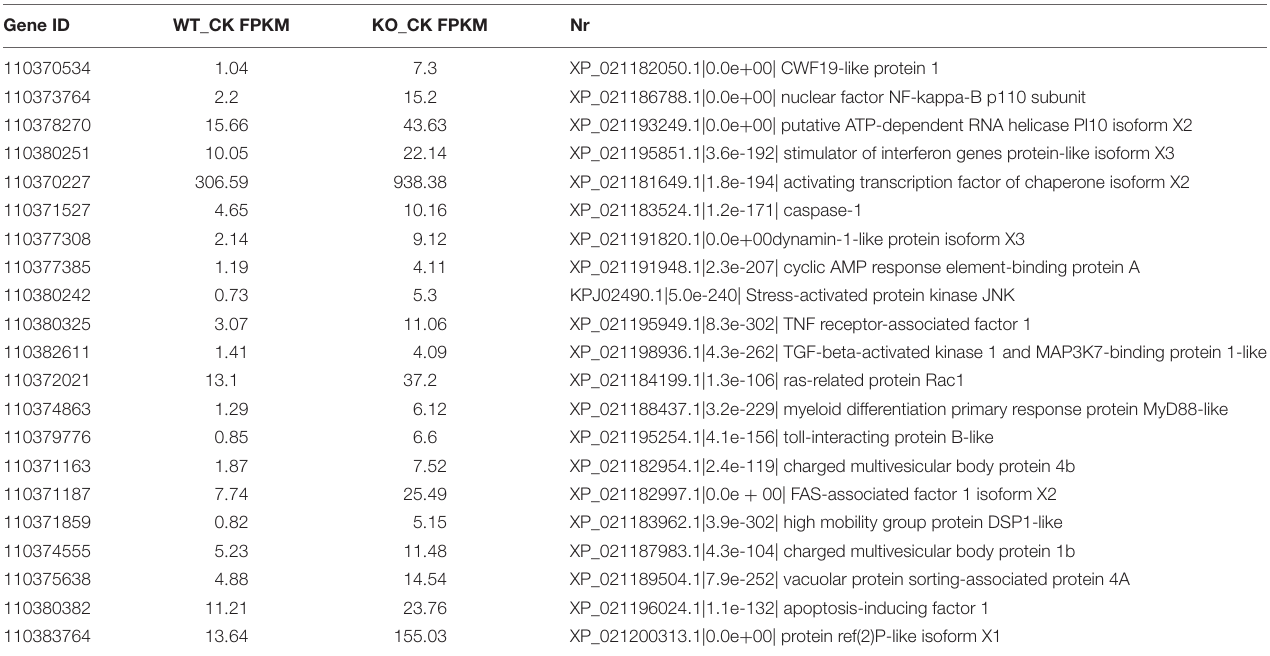
FIGURE 3 | Analysis of the transcriptomes of KO and WT cotton bollworm. (A) Number of differentially expressed genes in KO compared with WT. (B) Volcano plot of the differentially expressed genes. (C) Top 20 KEGG pathways assigned to the differential genes (|LogFC| ≥ 1, FDR < 0.005, FPKM(WT_CK + KO_CK) ≥ 5). TABLE 1 | Expression patterns of immune-related genes in WT and KO cotton